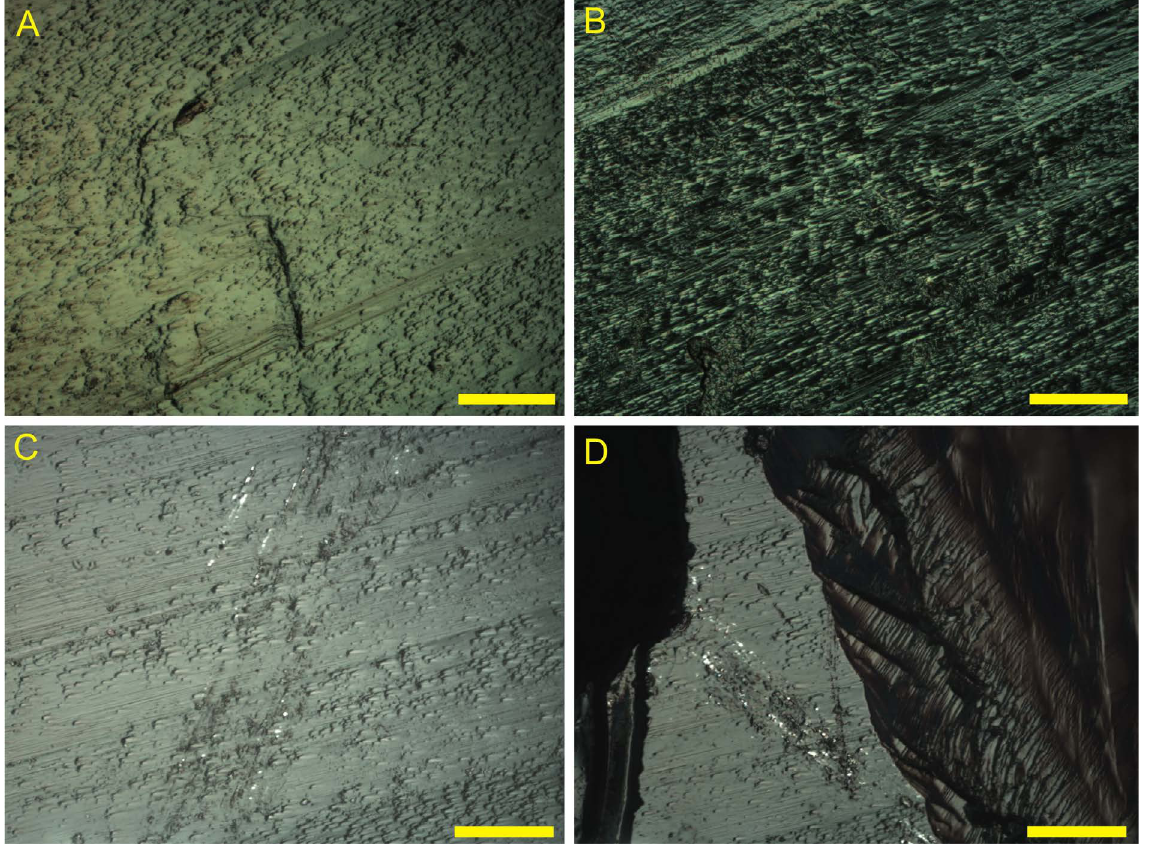
Figure 8. Details of the dorsal surface; A & B. unaltered cortical surface; C & D. bright striations. In image C the striations (quasi-vertical arrangement) overlap the growth lines (quasi-horizontal arrangement). The original magnification of all images is 200x and the graphic scale bars correspond are 100